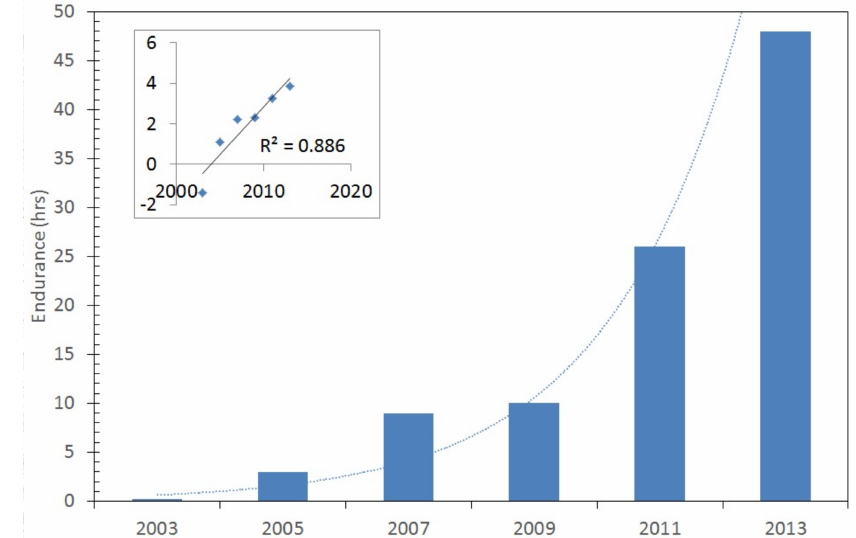
Figure 1. Endurance of various fuel-cell powered aerial vehicles as developed over time. The overlaid exponential trend is statically significant at the 99.7% confidence level and is given in the